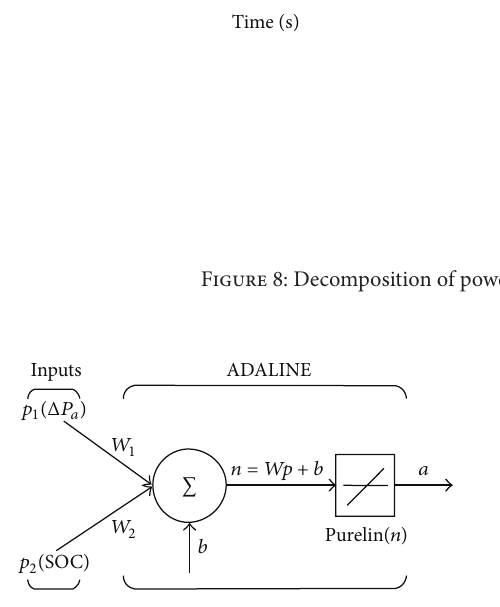
weight of the two inputs parameters; 𝑏 represents bias and 𝑛 represents the net input; 𝑎 is the output of the network controller. In this case, the inputs of the neural network are